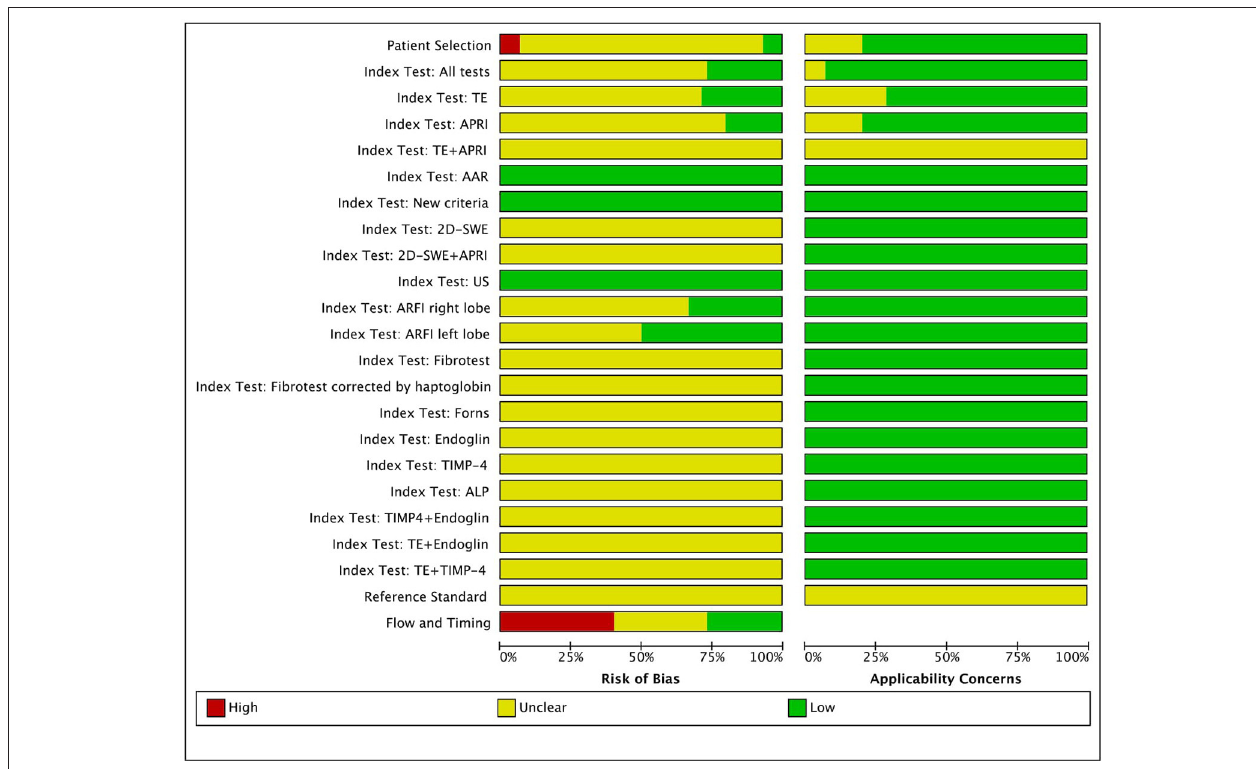
FIGURE 3 | Risk of bias and applicability assessment. TE, transient elastography; APRI, AST-to-platelet-ratio index; AAR, AST-to-ALT ratio; 2D-SWE, two-dimensional shear wave elastography; US, ultrasonography; ARFI, acoustic radiation force impulse; TIMP-4, tissue inhibitor of metalloproteinase-4; ALP, alkaline phosphatase.